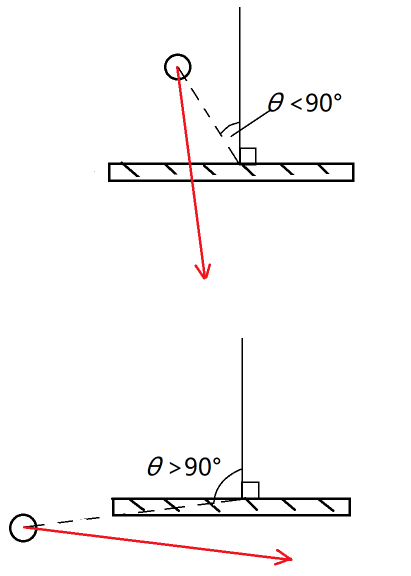
Figure 9. ( top ) Less than 90 degrees case; ( bottom ) Greater than 90 degrees